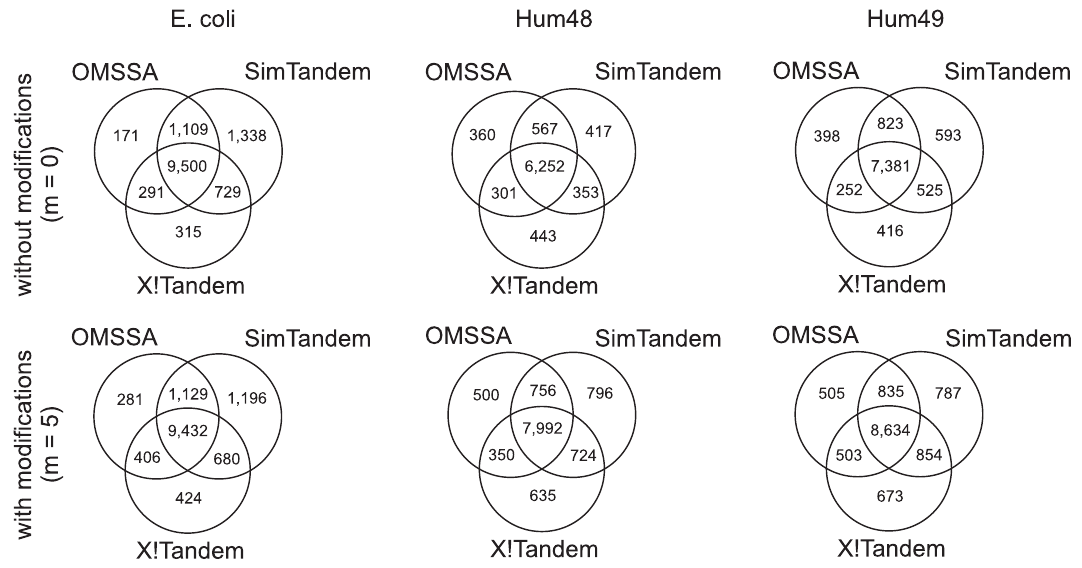
Figure 2: Numbers of peptides identified by SimTandem, OMSSA and X!Tandem ( q-value = 0 : 01